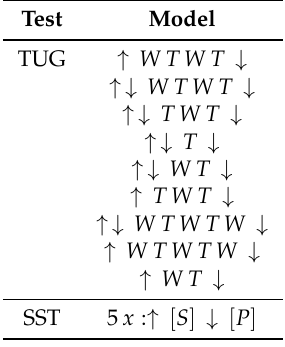
Table 3. Included test classification models for the following listed activities: sit-to-stand ( ↑ ), Walk (W), Turn (T), Stand (S), sit (P), stand-to-sit ( ↓ ); [] indicates optional activities, which might change per